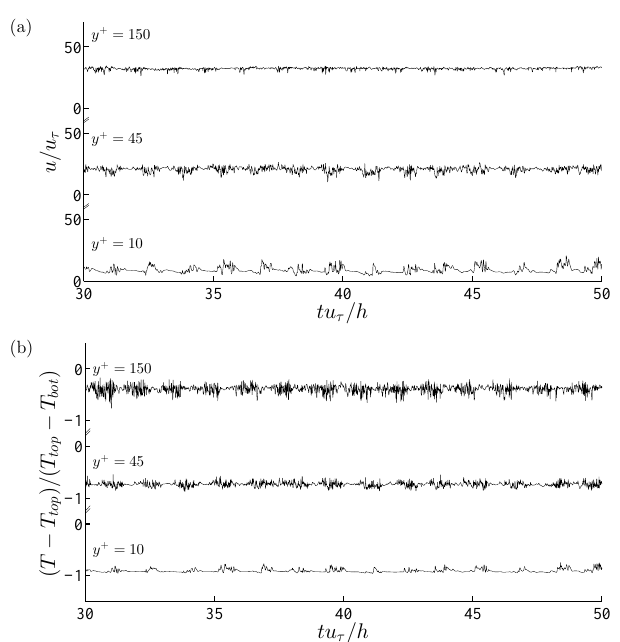
Figure 5. Time series of streamwise velocity and temperature in the channel at Re τ = 180, Ri τ = 120. (a) Streamwise velocity, u , and (b) temperature, T .